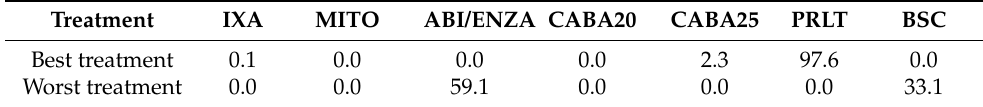
Table 3. Ranking of treatments regarding PSA response.